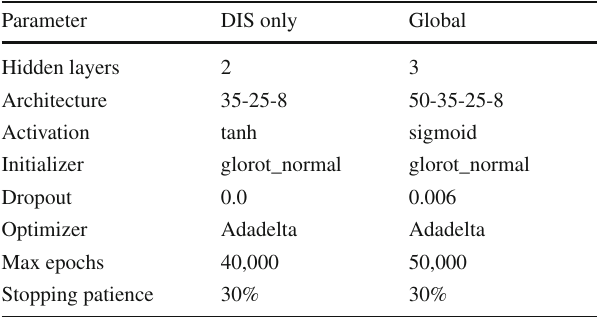
Table 4 Best models found by our hyparparameter scan for the DIS and global setups using the new n3fit methodology Parameter DIS only